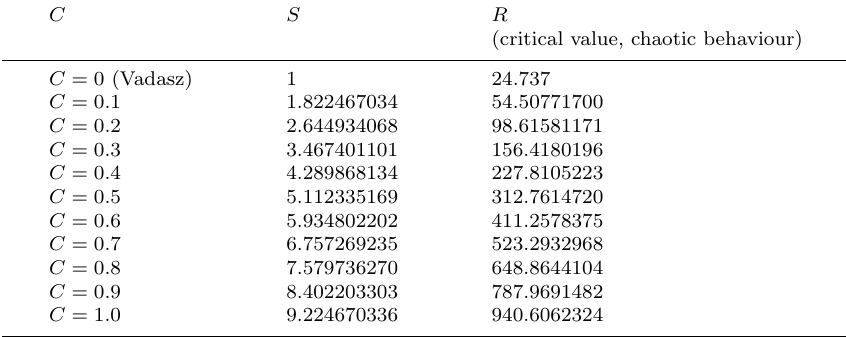
Comparison between Vadasz case ( C = 0) and the couple-stress case ( C (cid:54) = 0) with Pr = 10, λ = 8 / 3 for the critical value of R at which the chaotic behaviour solution